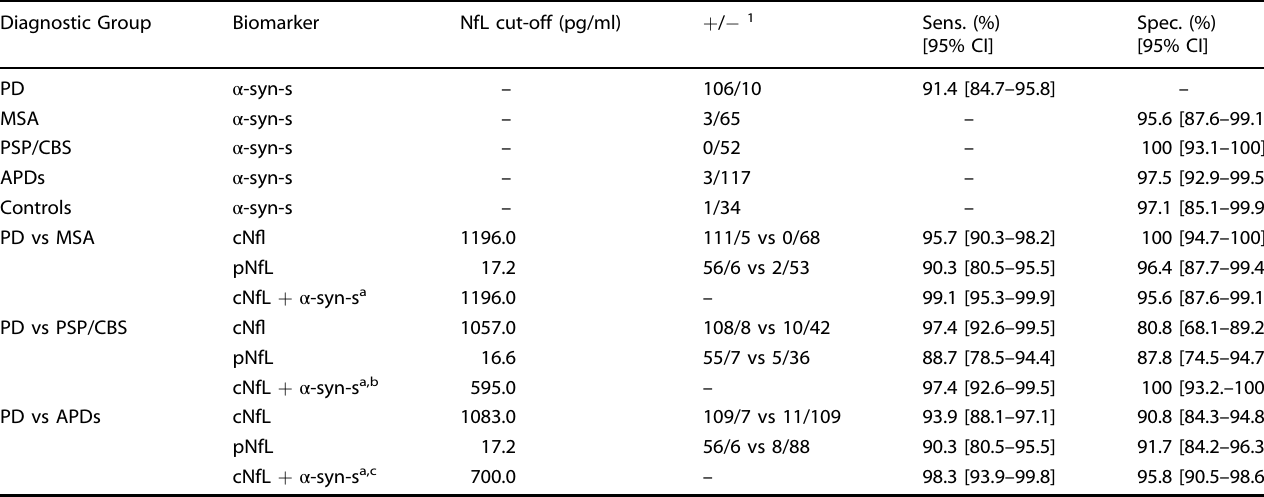
Table 3. Sensitivity and speci fi city of the NfL and α -syn RT-QuIC assays in patients with PD and APDs. Diagnostic Group